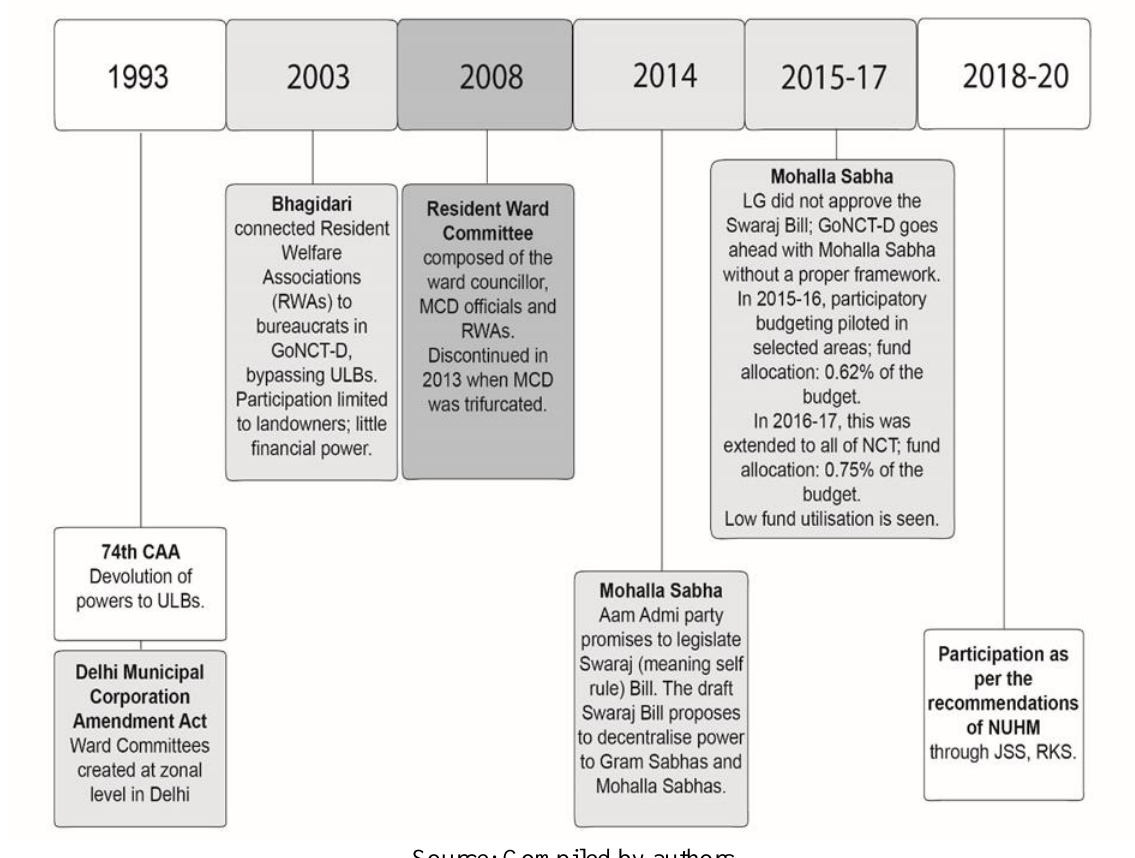
Figure 17: Incremental but fragmented initiatives of participatory governance in Delhi